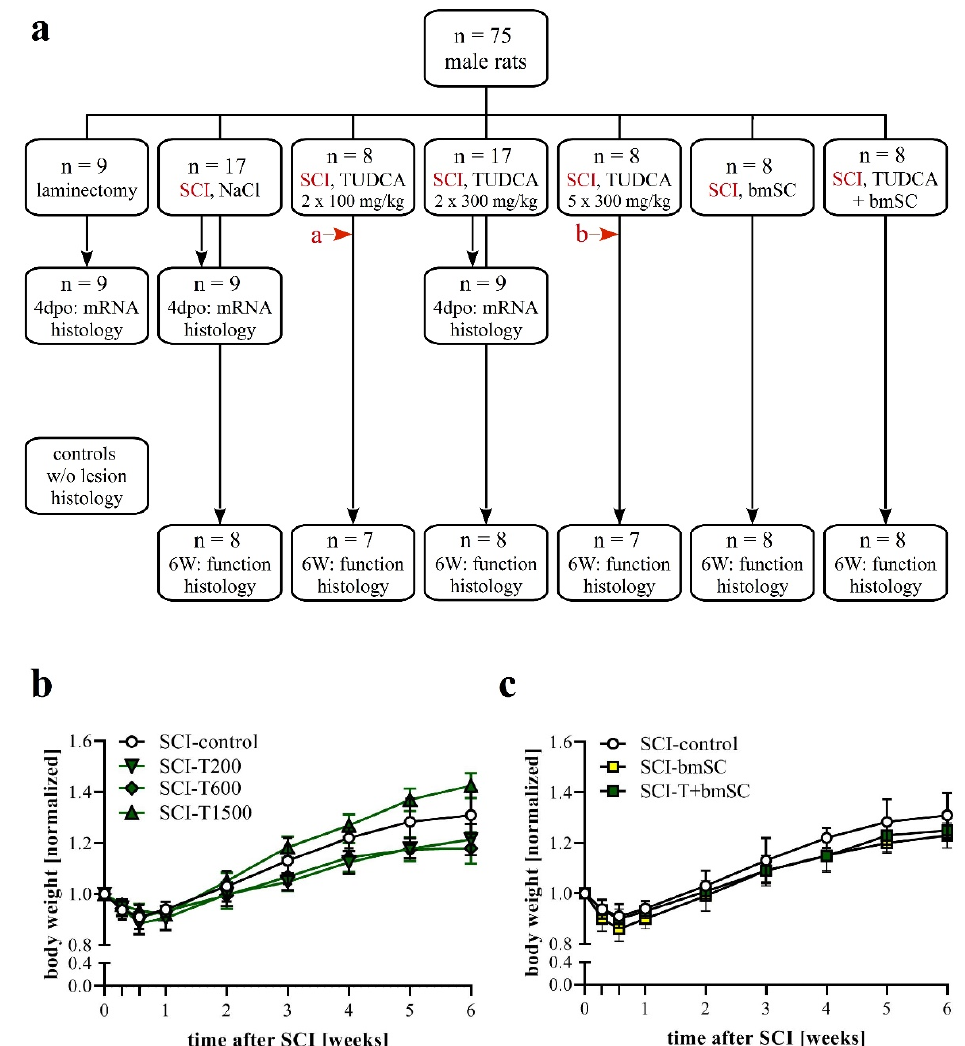
Figure 1. Experimental plan. ( a ) Animals were pseudo-randomly assigned to the different treatment groups. Functional analysis was carried out during a recovery period of six weeks after SCI with the following treatment conditions: (1) two injections of saline at the time of surgery (t0) and 24 h later, (2) two injections of 100 mg/kg TUDCA at t0, 24 h; (3) two injections of 300 mg/kg TUDCA at t0, 24 h; (4) five injections of 300 mg/kg TUDCA at t0, 24 h, 2 dpo, 4 dpo and 6 dpo; (5) one injection of bmSC at t0 + 2 h; (6) combinatorial treatment with bmSC and two injections of 100 mg/kg TUDCA.